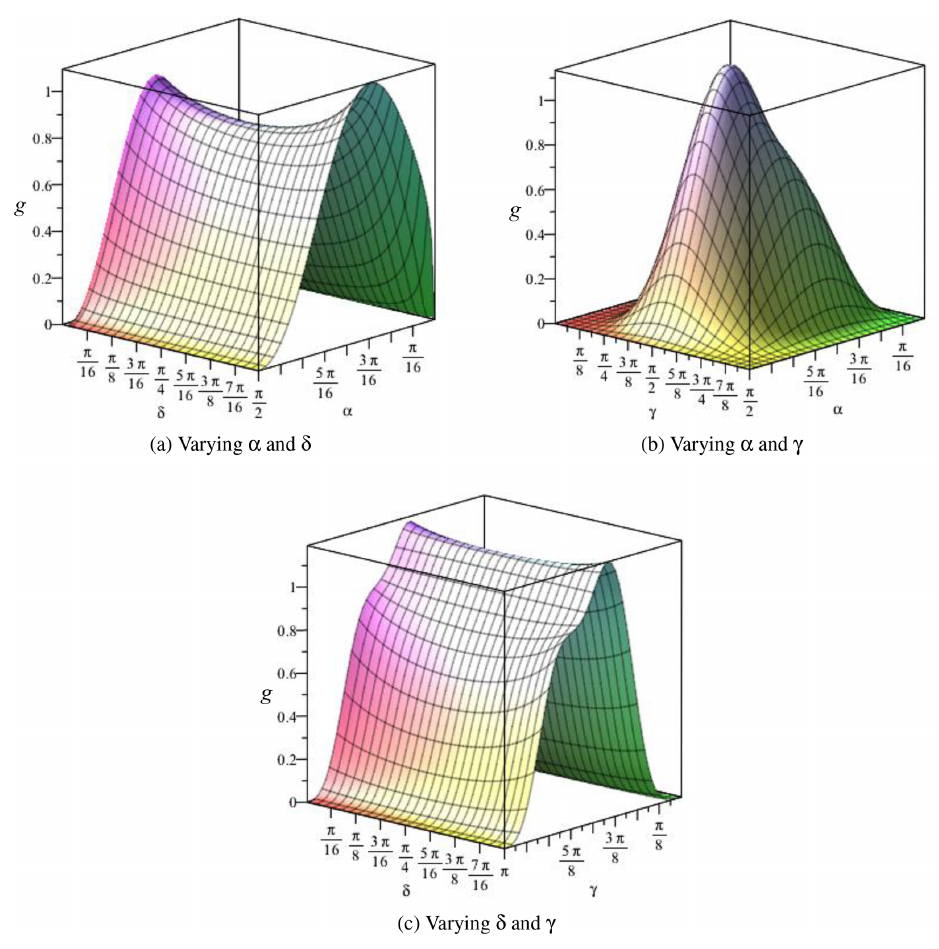
Figure 5. Variations of g with varying shape parameters for a pose z = 0 . 5 m, φ = ψ = 0 . 2 rad (11 . 46 ◦